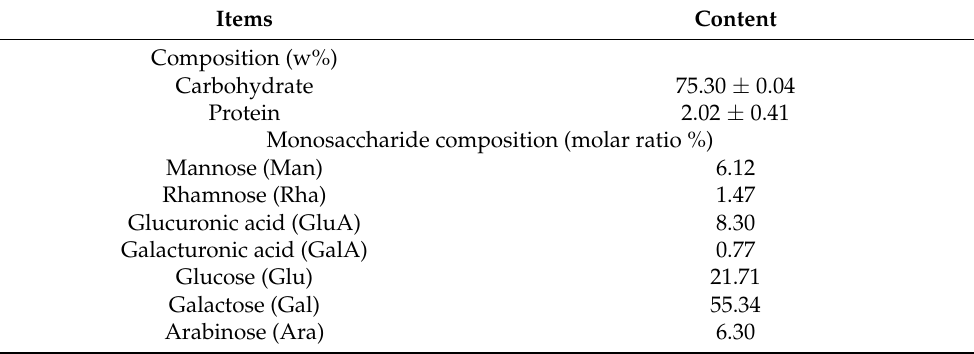
Table 2. Chemical properties and monosaccharide composition of